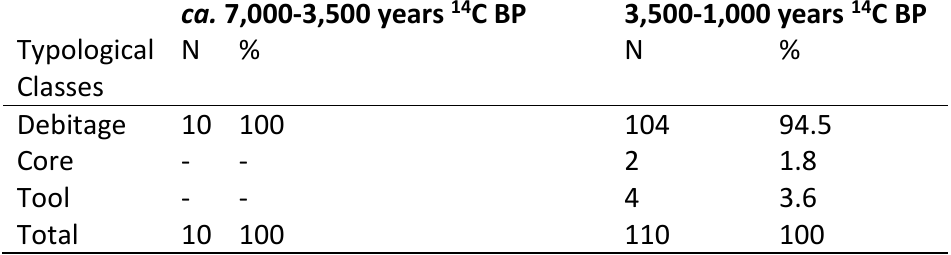
Table 4. Typological Structure of the assemblages from each period.